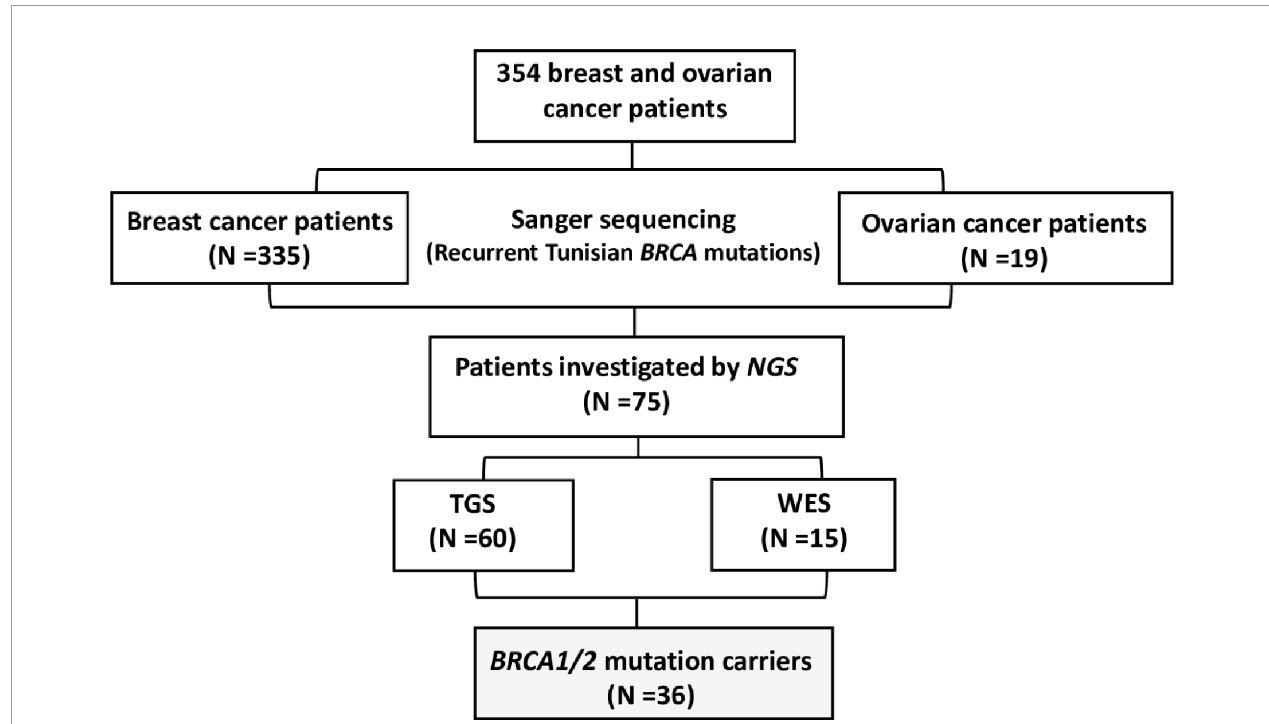
FIGURE 1 | Study fl